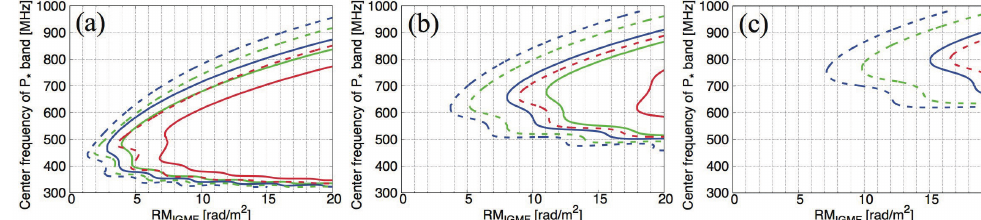
Figure 5. Error profiles between the input RM IGMF and the P ∗ -band center. Results for δφ MW = 2, 4, 6 rad m − 2 are shown from ( a – c ), respectively. The blue, green and red lines show the contours on which RM IGMF is determined with statistical errors of 30%, 20% and 10%, respectively. The solid and dashed lines are the results with 20-MHz and 40-MHz bandwidths of the P ∗ band,